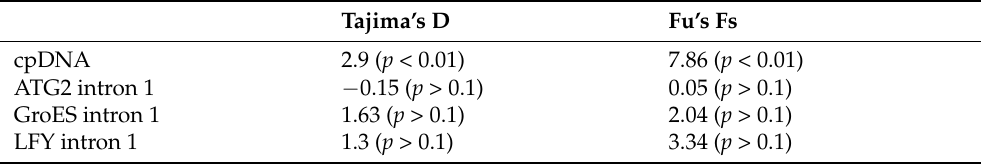
Table 2. Neutrality tests of four molecular markers estimated from the China populations.